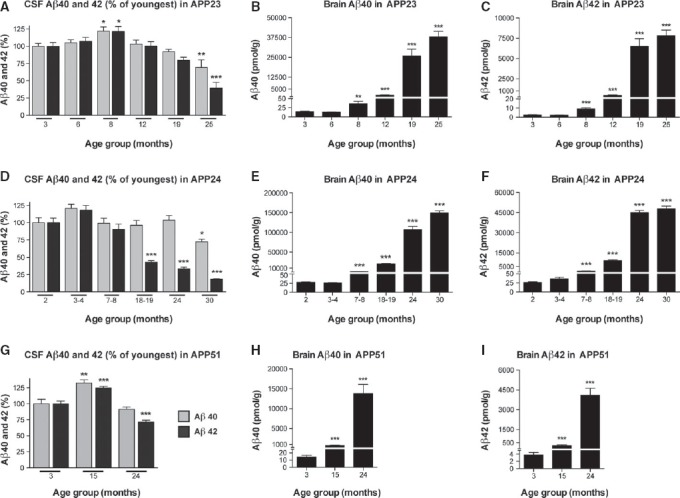
Human Aβ in CSF and brain of APP transgenic mice

A APP23 CSF Aβ40 and Aβ42 in the same animals as shown in Fig1. CSF Aβ42 and Aβ40 are expressed as percentages of levels measured in the youngest age group.

B, C Aβ40 and Aβ42 (pmol/g wet brain) in the FA-soluble brain extract from the same APP23 mice showed a robust increase with age; ANOVA revealed a significant cubic trend (F(1, 56) = 221.114, P < 0.001 and F(1, 56) = 370.947, P < 0.001, respectively).

D APP24 CSF Aβ40 and Aβ42 in the same animals shown in Fig1 as percentage of the youngest age group.

E, F Aβ40 and Aβ42 (pmol/g wet brain) in the brain from the same APP24 mice also showed a robust increase with age; ANOVA revealed a significant cubic trend (F(1, 86) = 202.173, P < 0.001 and F(1, 86) = 139.941, P < 0.001, respectively).

G APP51 CSF Aβ40 and Aβ42 in the same animals shown in Fig1 as percentages of levels in the youngest age group.

H, I Aβ40 and Aβ42 (pmol/g wet brain) in the brain from the same APP51 mice showed a robust increase with age; ANOVA revealed a significant quadratic trend (F(1, 19) = 12.960, P = 0.002 and F(1, 19) = 19.366, P < 0.001, respectively).
Data information: Post hoc Dunnett's test group comparisons were always conducted between the youngest group and all other groups. All data are represented as group means ± SEM; *P < 0.05; **P < 0.01; and ***P < 0.001.